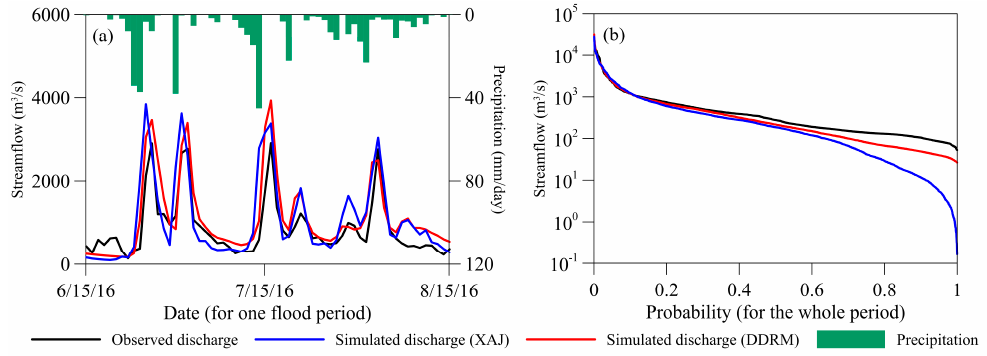
Figure 8. Observed daily discharge (black lines) for the Qujiang catchment compared with simulated discharge from XAJ model (red lines) and DDRM (blue line) and corresponding precipitation (green-shaded) during the flood period (6.15–8.15) of 2016 ( a ). ( b ) Observed and modelled daily flow duration curve during the whole period of 2010–2016.